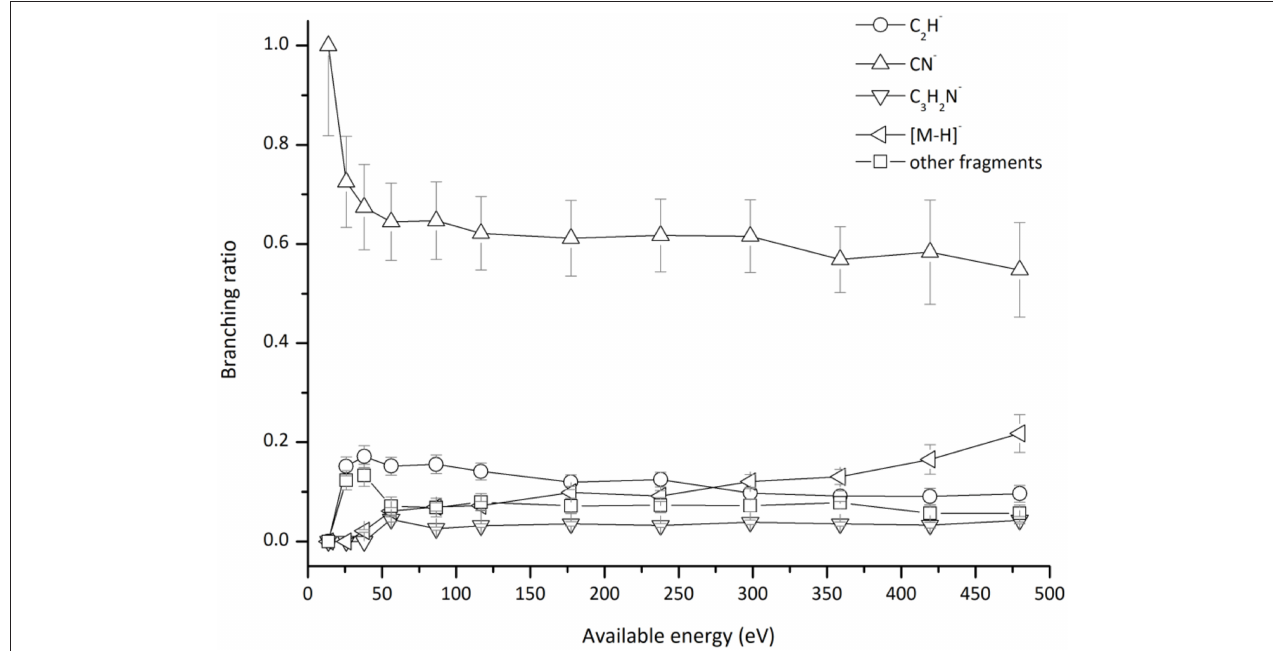
FIGURE 5 | Pyrimidine (Pyr) branching ratios (fragment anion yield/total anion yield) of the main negative ions formed as a function of the collision energy in the center-of-mass frame. See text for